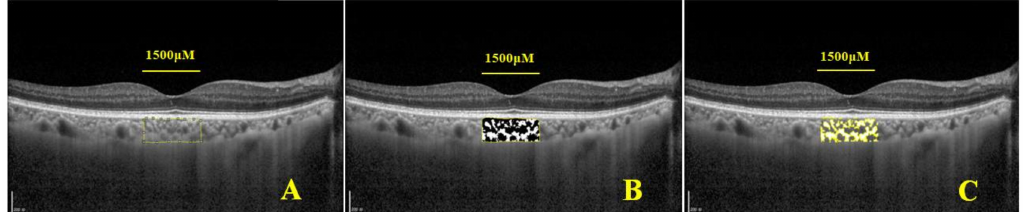
Figure 3. Choroidal image binarization and CVI measurement procedure: ( A ) Using the polygon selection tool in Image J, the choroidal region of interest (ROI) area was marked with Bruch’s membrane as the upper boundary and the sclerochoroidal interface as the lower boundary. The fovea was the center, and both nasal and temporal distances were 750 µ m. The total choroidal area (TCA) of the subfovea was calculated. ( B ) Eight-bit conversion of the image was performed, and Niblack Auto Local Threshold tool was used to binarize the selected area. ( C ) After converting the image of selected area to RGB colors, the dark pixels were selected with the color threshold tool to calculate the area of luminal area